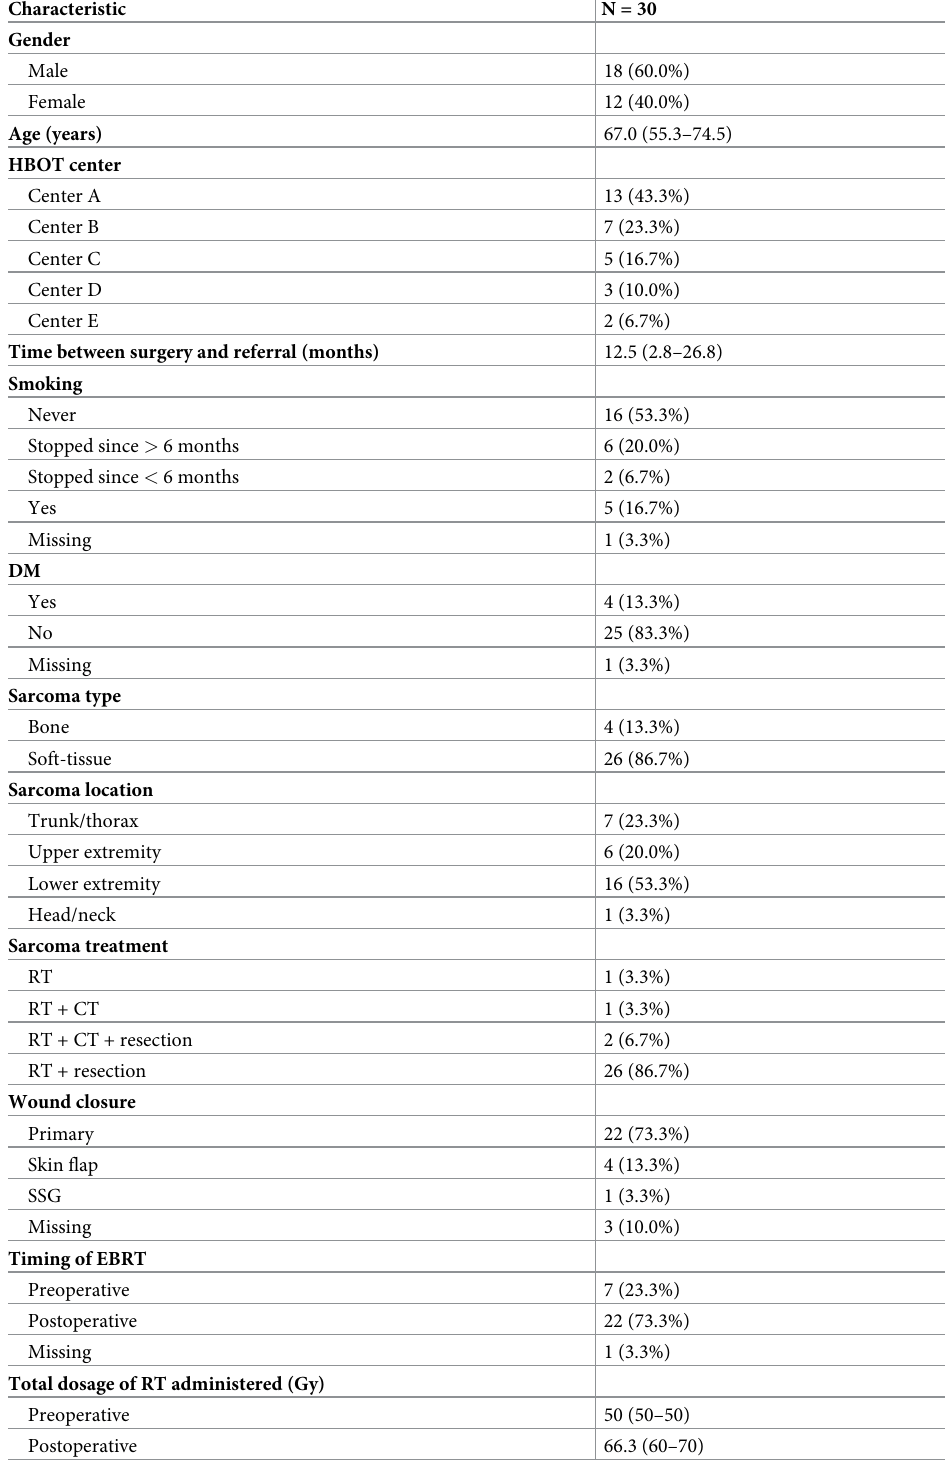
Table 1. Patient, tumor and sarcoma treatment